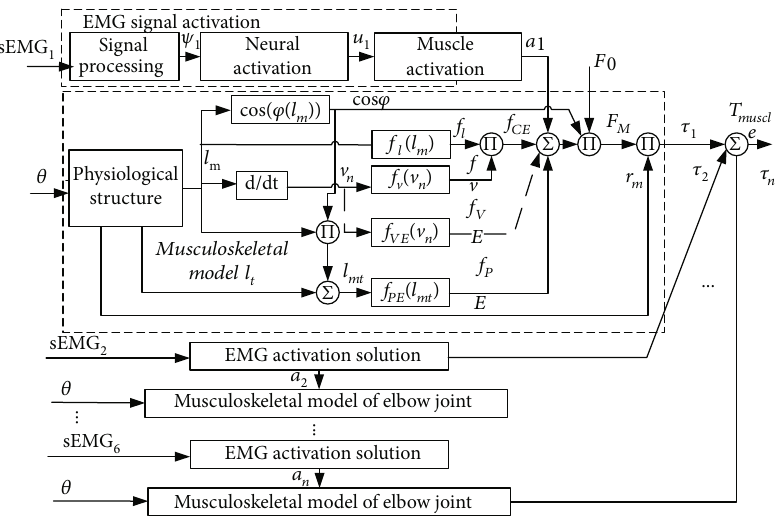
Figure 6: Elbow muscle torque prediction work fl ow. Table 1: Values of formula parameters in the musculoskeletal model in this paper. Item